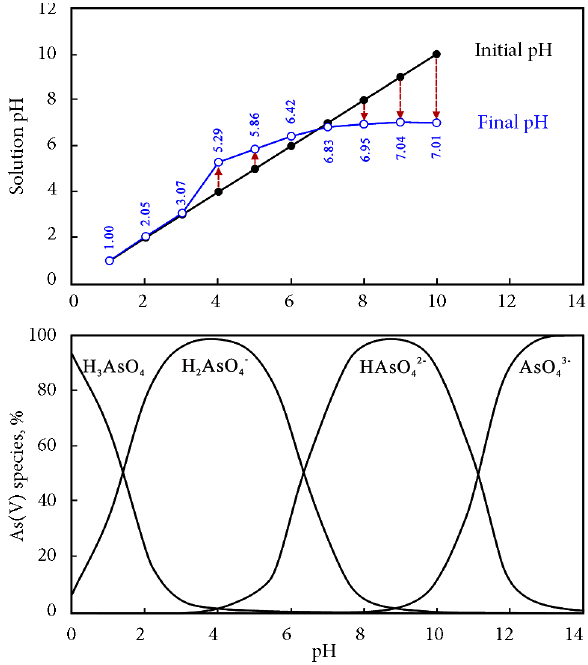
Figure 10. Variation of the As(V) species distribution with solution pHs (As(V) = 20 mg/L, 35 °